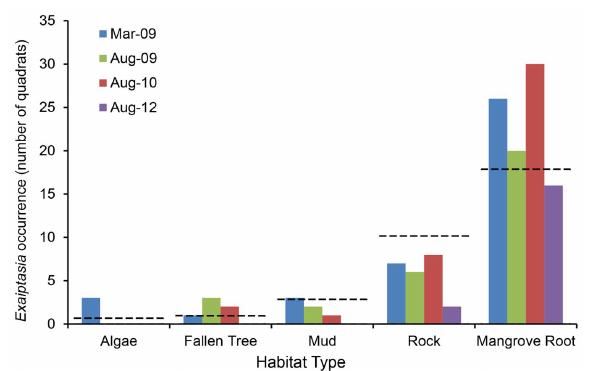
Figure 5. Number of quadrats containing Exaiptasia pallida , by substrate and by survey date in Jellyfish Lake (Ongeim’l Tketau, Mecherchar). Dashed black line shows expectation of quadrats containing E. pallida if the invasive anemone is randomly distributed in proportion to the availability of different habitat types. The figure shows lower than expected occurrence on rock and mud habitats and higher than expected occurrence on mangrove roots and fallen